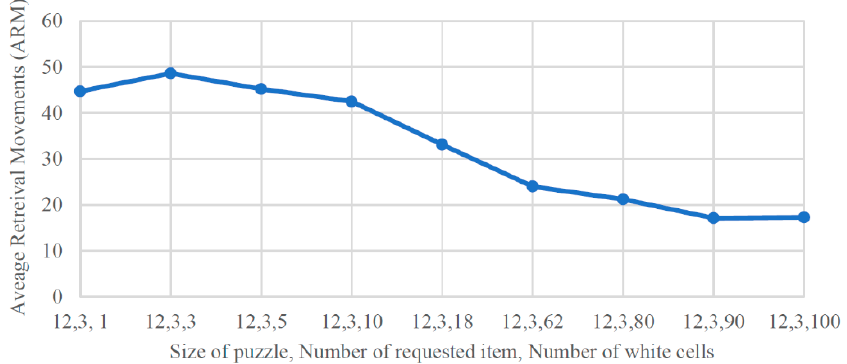
Figure 16. The effect of the number of white cells on the ARM in a 12 × 12 puzzle.